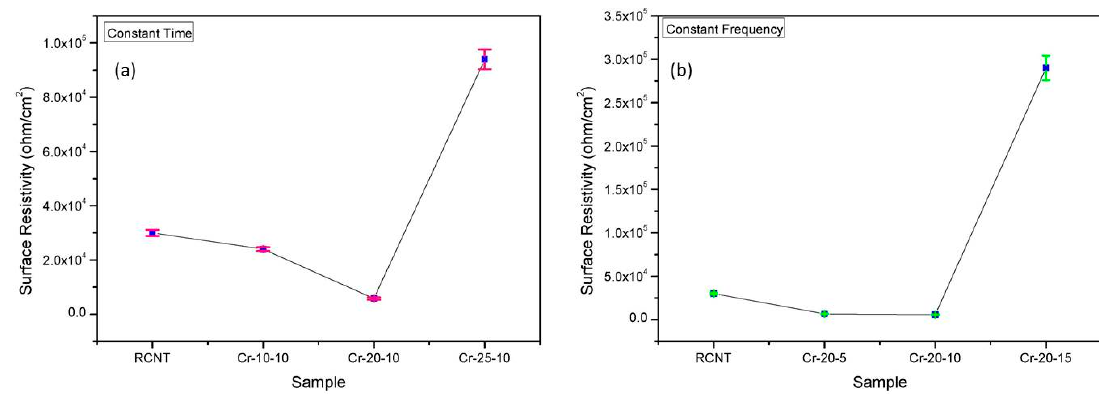
Figure 8. Surface resistivity of the different CNT/PMMA composites: ( a ) RCNT, Cr-10-10, Cr-20-10, and Cr-25-10; and ( b ) RCNT, Cr-20-5, Cr-20-10, and Cr-20-15. The sample Cr-20-10 shows higher conductivity in comparison to the others due to a better dispersion and proper conductive network.